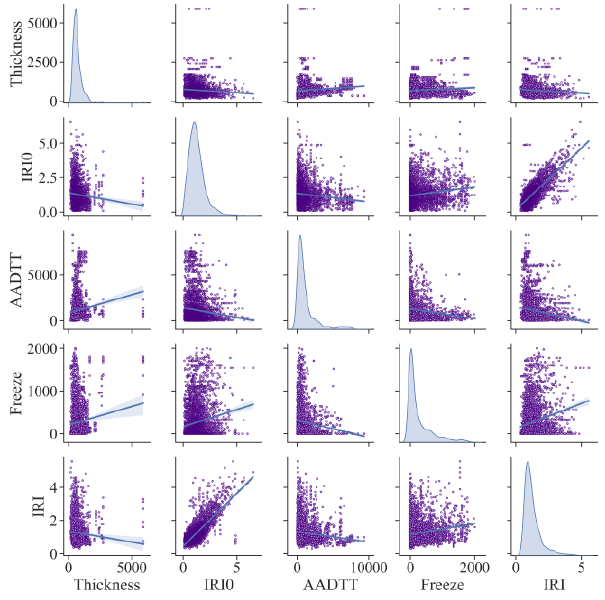
Figure 11. Variable correlation analysis matrix diagram.